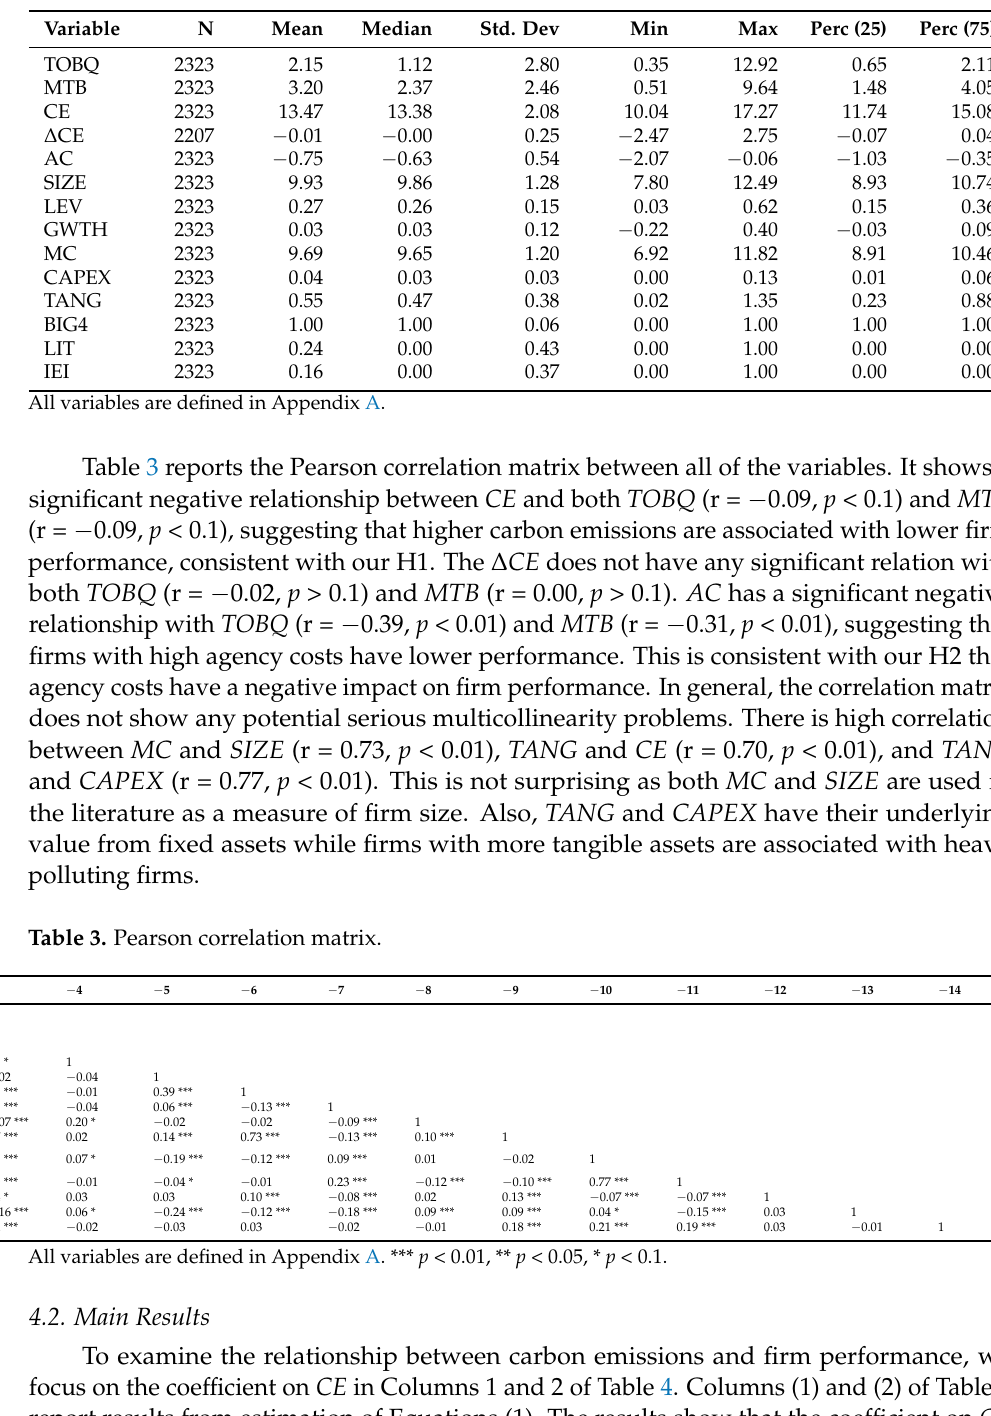
Table 2. Descriptive statistics.